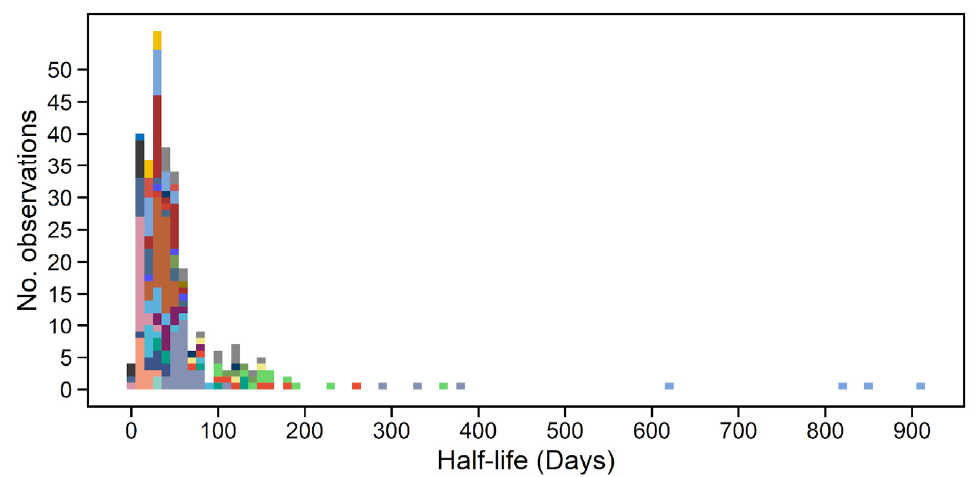
Figure 3. Histogram of the distribution of the imidazolinone half-life values in the selected search records. Each record ′ s values by assigning a color palette to the selected records employed throughout this study which was included on Supplementary Figure S3.